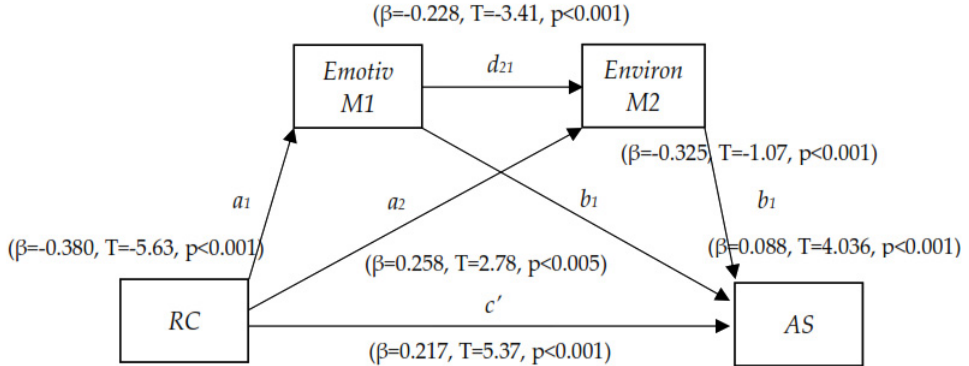
Figure 1. Coefficients of the relationship between mediating, criteria and predicted variables. Note: Indirect effect of X on Y through M i only = a i b i ; Indirect effect of X on Y through M i and M 2